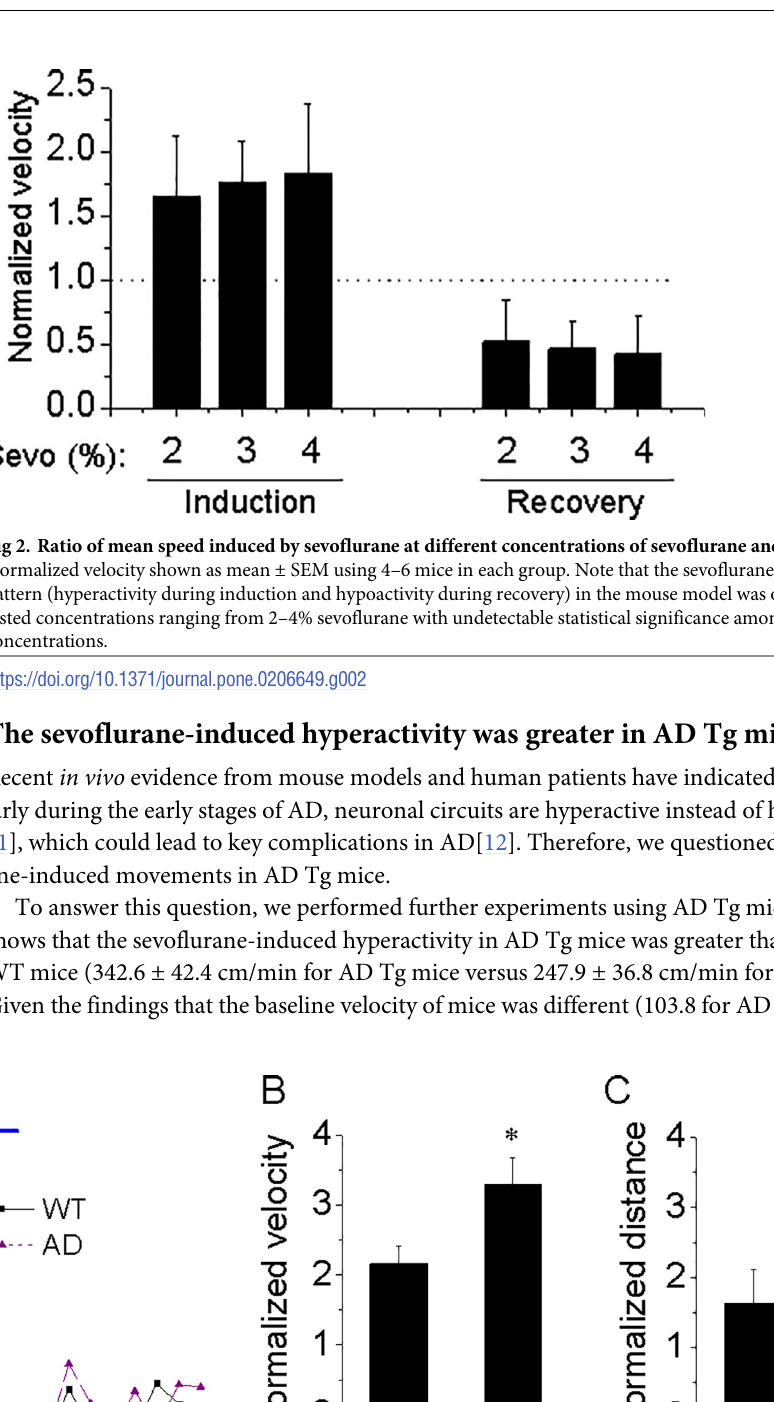
PLOS ONE | https://doi.org/10.1371/journal.pone.0206649 May 21,